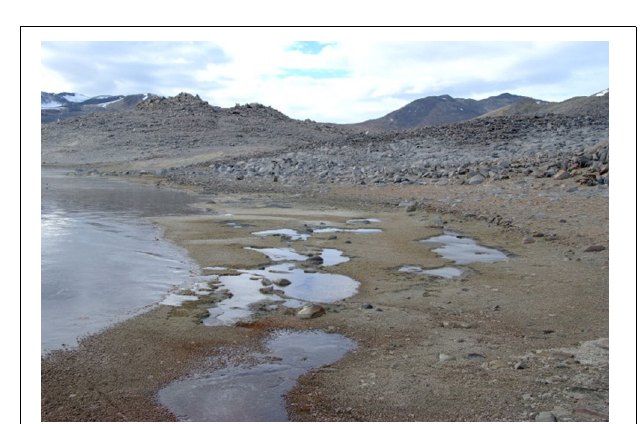
FIGURE 2 | Rocky soils of the high altitude Beacon Valley.